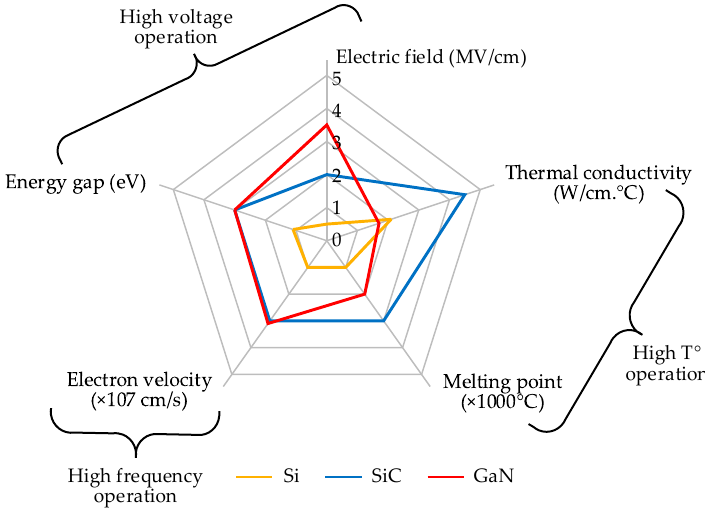
Figure 17. Comparison between Si, silicon carbide (SiC) and gallium nitride (GaN) power modules .